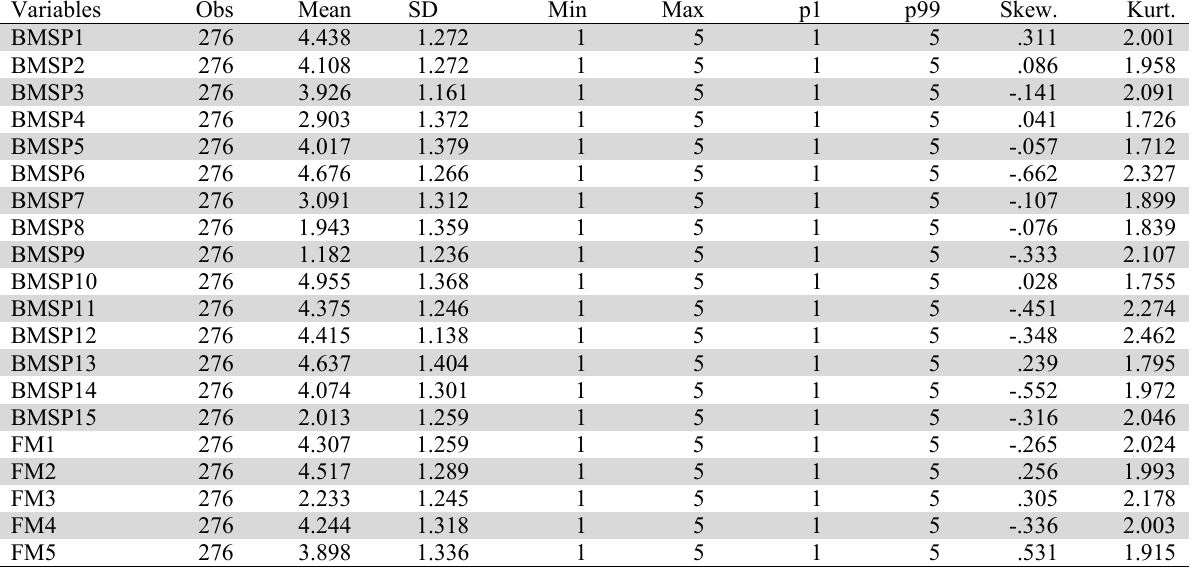
Table 2 presumes correlational coefficients among all the items of strategic planning for business man- agement. Correlation between BMSP1 and BMSP2 is positively moderate and significant at five per- cent. Similar positive and significant trend is found between first and third item, between first and fourth item between first and sixth item, between first and seventh item, between first and 10 th item of business management. While for BMSP2, the highest correlation is examined with BMSP10. As per BMSP3, correlation is .351, significant at 5 percent with BMSP4 and with BMSP14 is .431. The rest of the indicators are showing a mixed trend but most of the correlation coefficients are found to be significantly positive. To address the queries for the problem of multicollinearity, VIF test is applied, measuring the tolerance and mean value of the tolerance for correlation. Table 3 presents individual correlation and mean value of tolerance under the title of Mean VIF. It is observed that all the items of strategic planning for business management had a mean score of below 2, and overall mean VIF is 1.386. As per the findings of earlier researchers, mean VIF less than five can be assumed as enough evidence to conclude that explanatory variables had no problematic level of